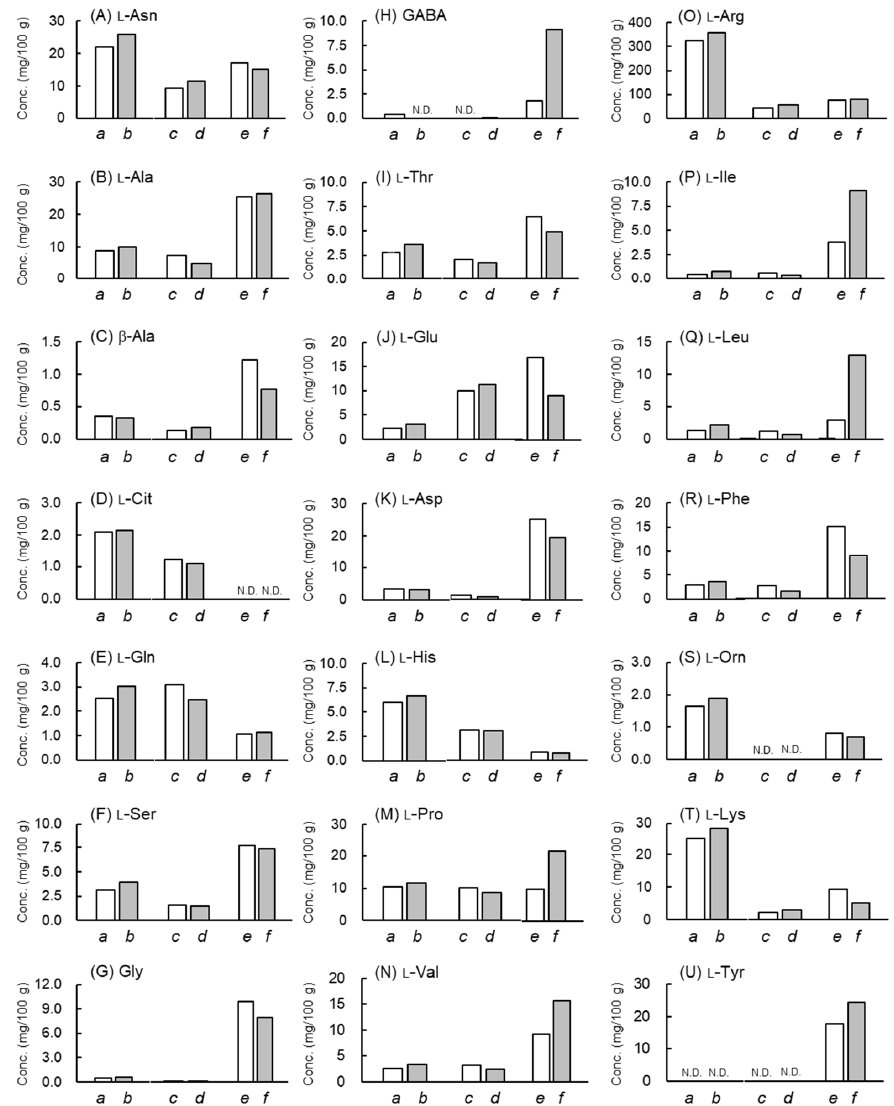
Figure 2. Concentrations (mg/100 g) of free L -amino acids in samples of grated raw garlic ( a , b ), freeze-dried garlic ( c , d ), and fermented BG ( e , f ), as determined in duplicate. ( A ) L -Asn, ( B ) L -Ala, ( C ) β-Ala, ( D ) L -Cit, ( E ) L -Gln, ( F ) L -Ser, ( G ) Gly, ( H ) GABA, ( I ) L -Thr, ( J ) L -Gln, ( K ) L -Asp, ( L ) L -His, ( M ) L -Pro ( N ) L -Val, ( O ) L -Arg, ( P ) L -Ile, ( Q ) L -Leu, ( R ) L -Phe, ( S ) L -Orn, ( T ) L -Lys, ( U ) L -Tyr. N.D.: not